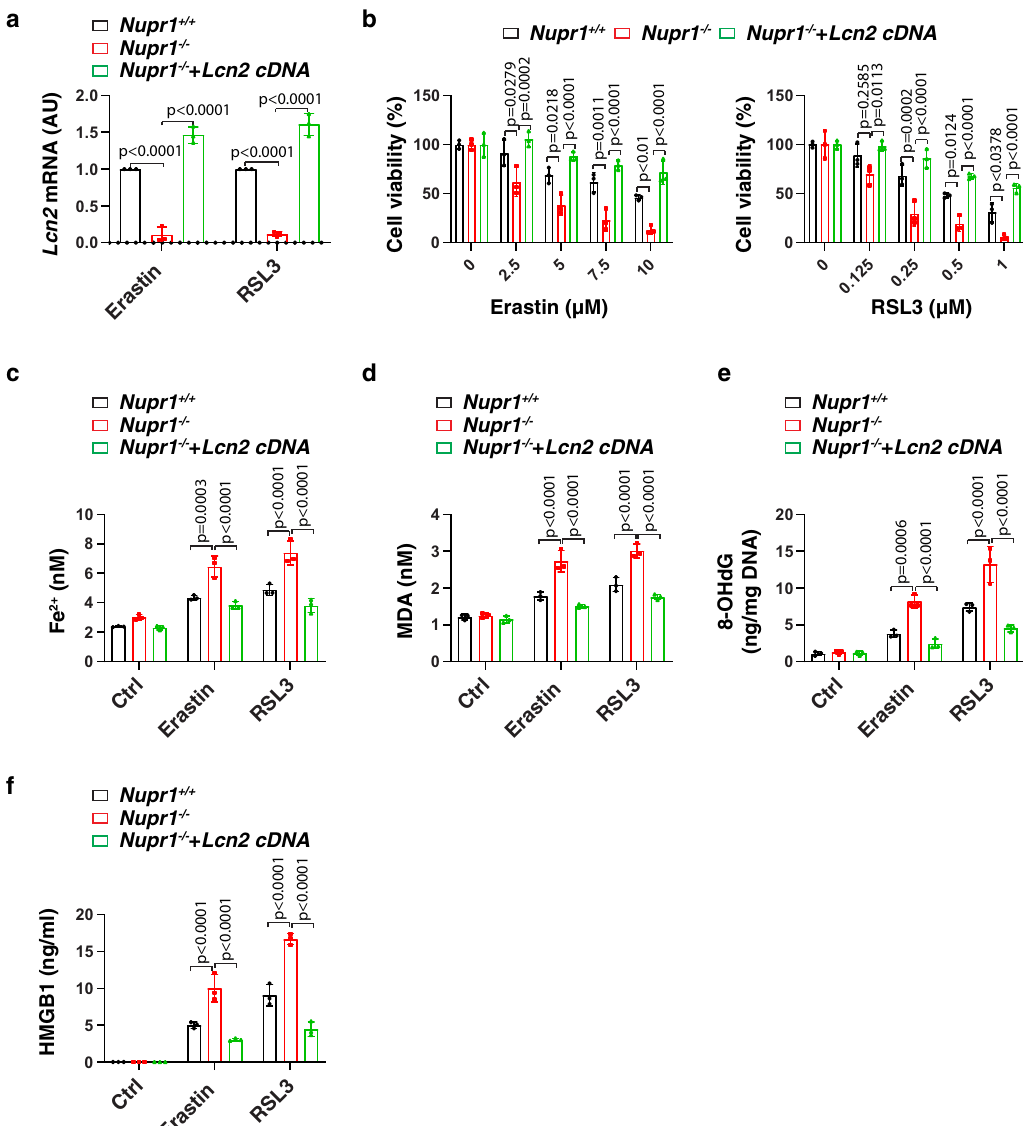
Fig. 4 Re-expression of LCN2 rescues ferroptosis resistance in Nupr1 -de fi cient cells. a qPCR analysis of Lcn2 mRNA in indicated mPDAC cells following treatment with erastin (10 µ M) or RSL3 (1 µ M) for 24 h ( n = 3 well/group, two-way ANOVA with Tukey ’ s multiple comparisons test on all pairwise combinations). b Cell viability in indicated mPDAC cells following treatment with erastin or RSL3 for 24 h ( n = 3 well/group, two-way ANOVA with Tukey ’ s multiple comparisons test on all pairwise combinations). c – f Indicated mPDAC cells were treated with erastin (10 µ M) or RSL3 (1 µ M) for 24 h, and then intracellular Fe 2 + ( c ), intracellular MDA ( d ), intracellular 8-OHdG ( e ), and extracellular HMGB1 were assayed ( n = 3 well/group, two-way ANOVA with Tukey ’ s multiple comparisons test on all pairwise combinations). Data in a – f are presented as mean ± SD. The results in a – f are representative of those from 2 to 3 independent experiments with three technical replicates LCN2 prevents pancreatitis . Excess iron is stored in multiple (Fig. 5e), all of which were inhibited by the ferroptosis inhibitor liproxstatin-1. In contrast, the apoptosis inhibitor Z-VAD-FMK or organs, including the pancreas, which may cause tissue injury and the necroptosis inhibitor necrosulfonamide had no effects on the in fl ammation under pathologic conditions 29 . We further exam- ined the effects of Lcn2 depletion-mediated iron accumulation on increased anticancer activity of IKE in NUPR1 KD or LCN21 KD PANC1 cells (Supplementary Fig. 5). ZZW-115, a potent NUPR1 L -arginine-induced acute pancreatitis in mice, a widely used inhibitor 28 , also increased the anticancer activity of IKE in PANC1 or experimental model that can cause pancreatic oxidative injury, sterile in fl ammation, and extensive necrosis 30 . We generated MIAPaCa2 xenograft mouse models (Fig. 5f). These animal studies pancreas-speci fi c Lcn2 -knockout mice ( Pdx1-Cre;Lcn2 fl ox/ fl ox , support the contention that the NUPR1 – LCN2 pathway limits the termed Lcn2 Pan − / − mice) by crossing Lcn2 fl ox/ fl ox and Pdx1-Cre anticancer activity of IKE. The synergistic effect on cell death by mice. Western blot con fi rmed the expression of LCN2 was ZZW-115 and erastin or RSL3 was diminished in Nupr1 − / − cells, but diminished in the pancreas (but not in the liver) from Lcn2 Pan − / − not in Nupr1 + / + cells (Fig. 5g), indicating that ZZW-115 bound mice, but not from control Lcn2 fl ox/ fl ox mice (Fig. 6a). Lcn2 Pan − / − NUPR1 possesses dominant negative activity or, in other words, the mice were more sensitive to L -arginine-induced acute pancreatitis, inhibition of NUPR1 is more effective than the loss of NUPR1.